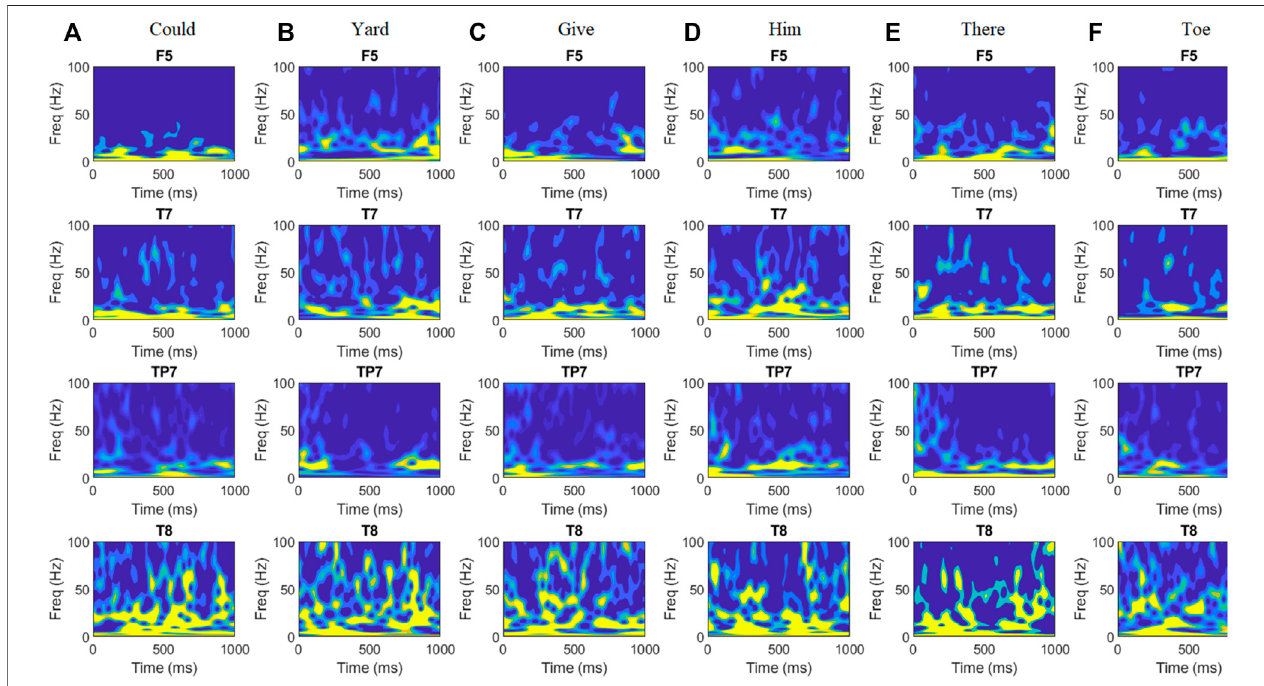
FIGURE 4 | Time-frequency representations (TFRs) of averaged EEG signals for six words (A) Could, (B) Yard, (C) Give, (D) Him, (E) There, and (F) Toe acquired from subject ID 2. The TFRs are plotted for the fi rst 1 s after stimulus onset and for the frequency range of 0 – 100 Hz. TFRs show high activation during 0 – 200 ms and around500 msinthelefttemporalregionaroundWernicke ’ sarea(T7,TP7).Maximumvariationinamplitudefordifferentwordscanbeobservedinthebetaandgamma bands in both temporal regions and Broca ’ s area (F5).